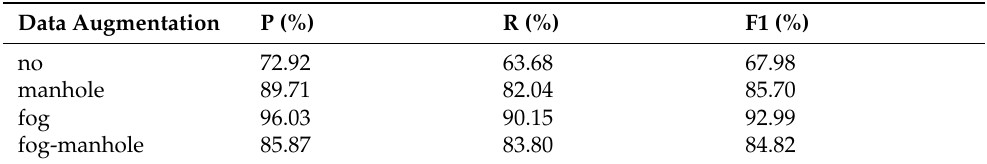
Table 5. Based on YOLOv5s model, compare the results of data augmentation in the self-made dataset.